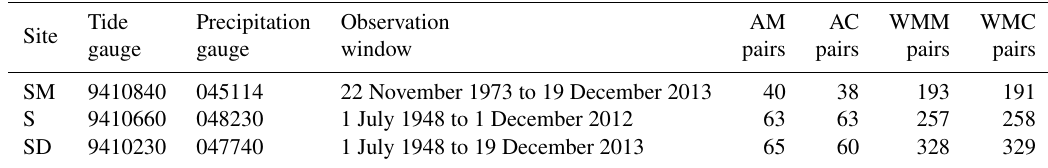
Table 2. Water level and precipitation observations at Santa Monica (SM), Sunset (S), and San Diego (SD) using annual maximum (AM), annual coinciding (AC), wet-season monthly maximum (WMM), and wet-season monthly coinciding (WMC) samplings. Tide Precipitation Observation AM AC WMM WMC Site gauge gauge window pairs pairs pairs pairs SM 9410840 045114 22 November 1973 to 19 December 2013 40 38 193 191 S 9410660 048230 1 July 1948 to 1 December 2012 SD 9410230 047740 1 July 1948 to 19 December 2013